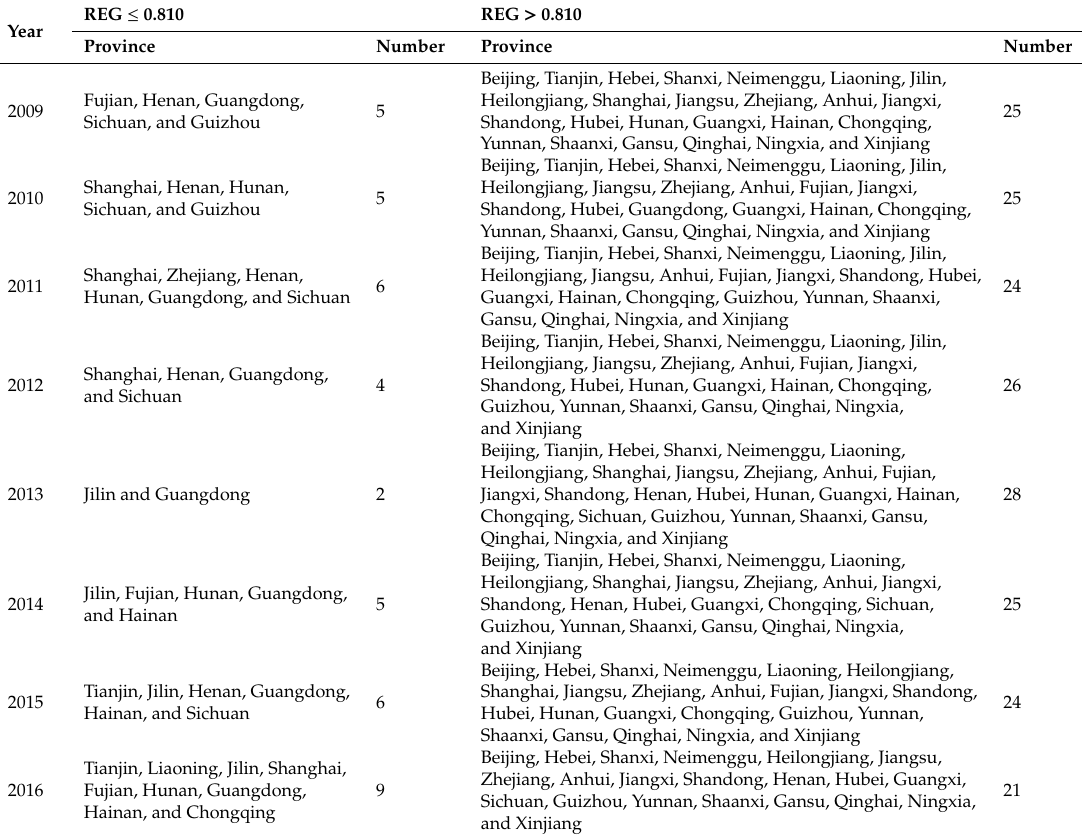
Table 6. Distribution of Chinese provinces with di ff erent threshold intervals for each